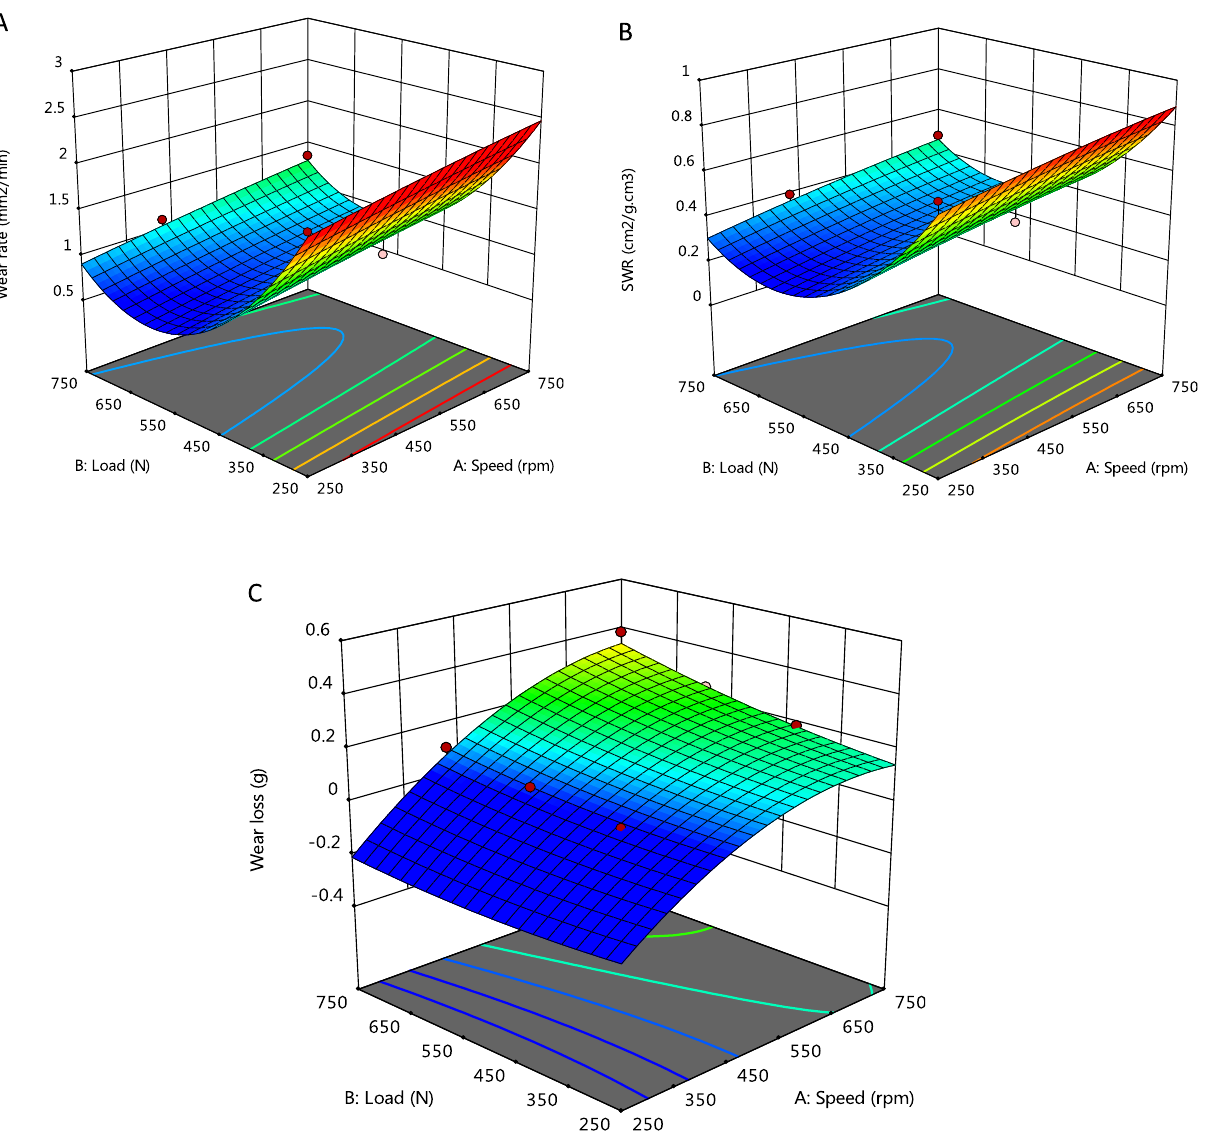
Figure 12. Interactive 3D surface model graphs for ( A ) wear rate, ( B ) specific wear rate, & ( C ) wear loss, against the design